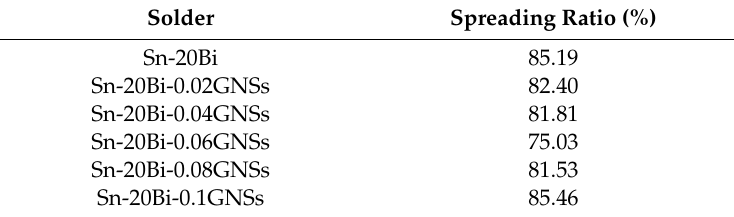
Table 2. Spreading ratio of Sn-20Bi-xGNS solder on Cu substrate.